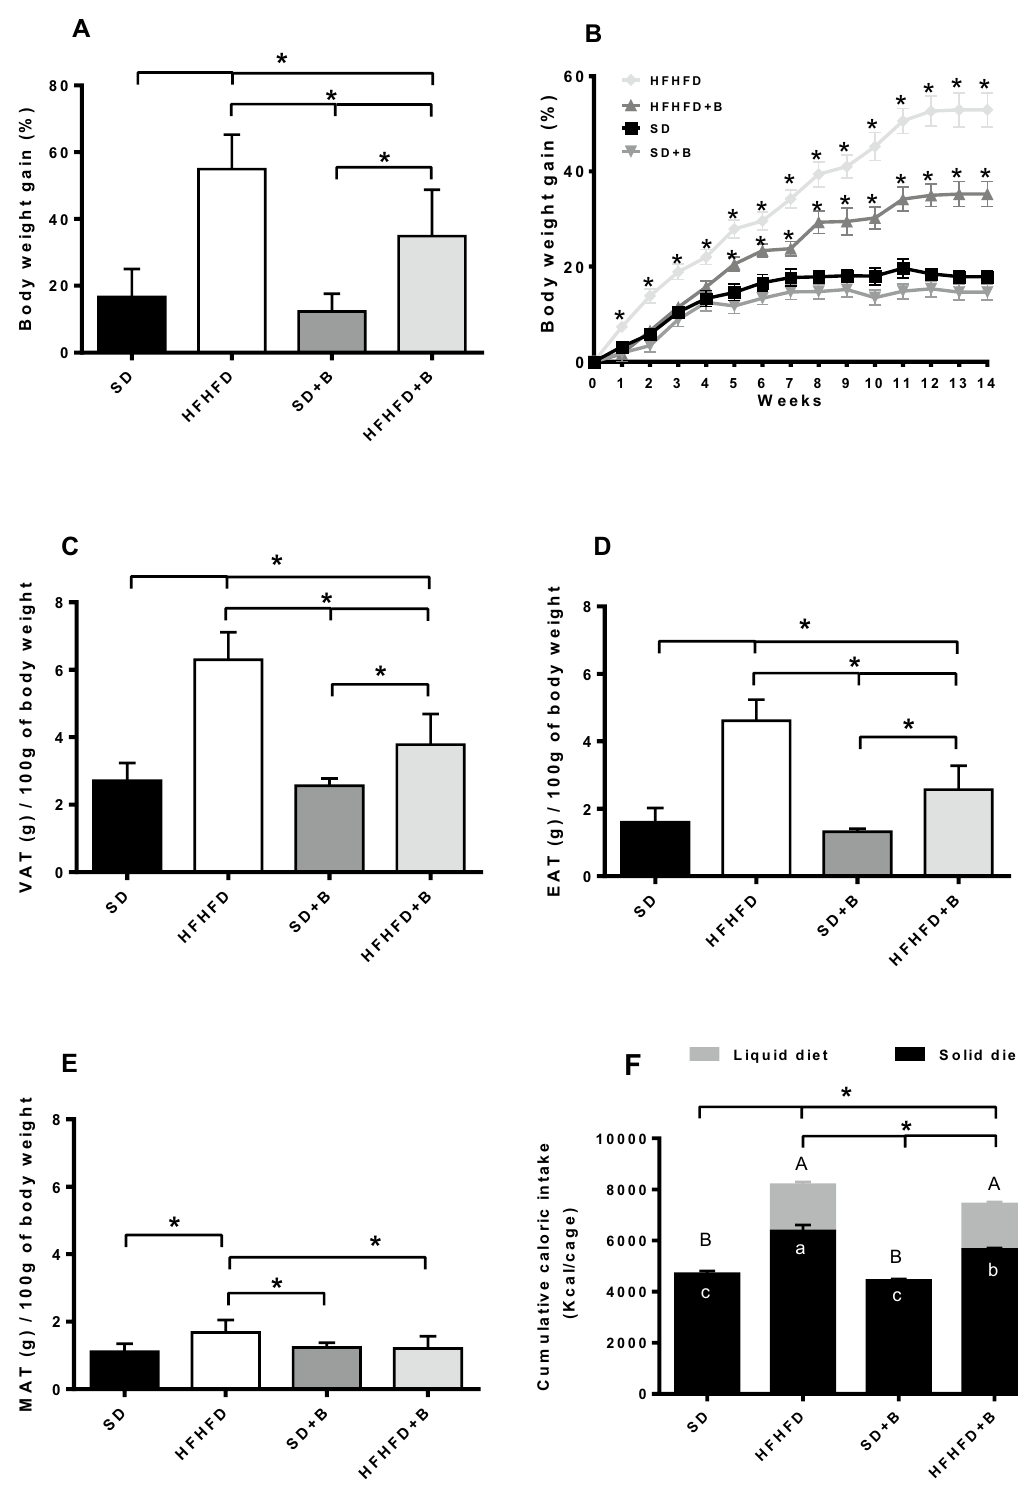
Figure 1. Anthropometric parameters and dietary intake. ( A ) Total body weight gain, ( B ) Weekly body weight gain ( C ) Visceral adipose tissue (VAT) weight, ( D ) Epididymal adipose tissue (EAT) weight, ( E ) Mesenteric adipose tissue (MAT) weight, ( F ) Cumulative caloric intake from liquid diet, solid food and total caloric intake. Data are expressed as mean and standard error (vertical bars). Significant differences for liquid diets, solid foods, and total caloric intake are represented by uppercase letters, lowercase letters and stars, respectively. Statistically significant differences were established by ANOVA and post hoc student t test ( p <